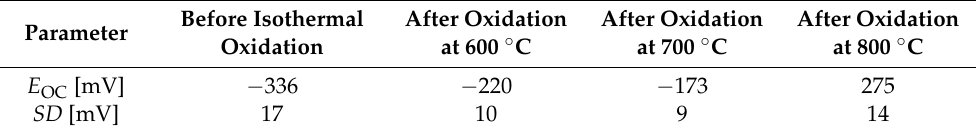
Figure 7. Open-circuit potential for the Ti-6Al-7Nb electrode before (–) and after isothermal oxidation at 600 ◦ C (–), 700 ◦ C (–) and 800 ◦ C (–) recorded in saline solution at 37 ◦ C. Table 2. The average value of the E OC with corresponding standard deviation determined for Ti-6Al-7Nb electrode before and after isothermal oxidation in saline solution at 37 ◦ C (see Figure 7).